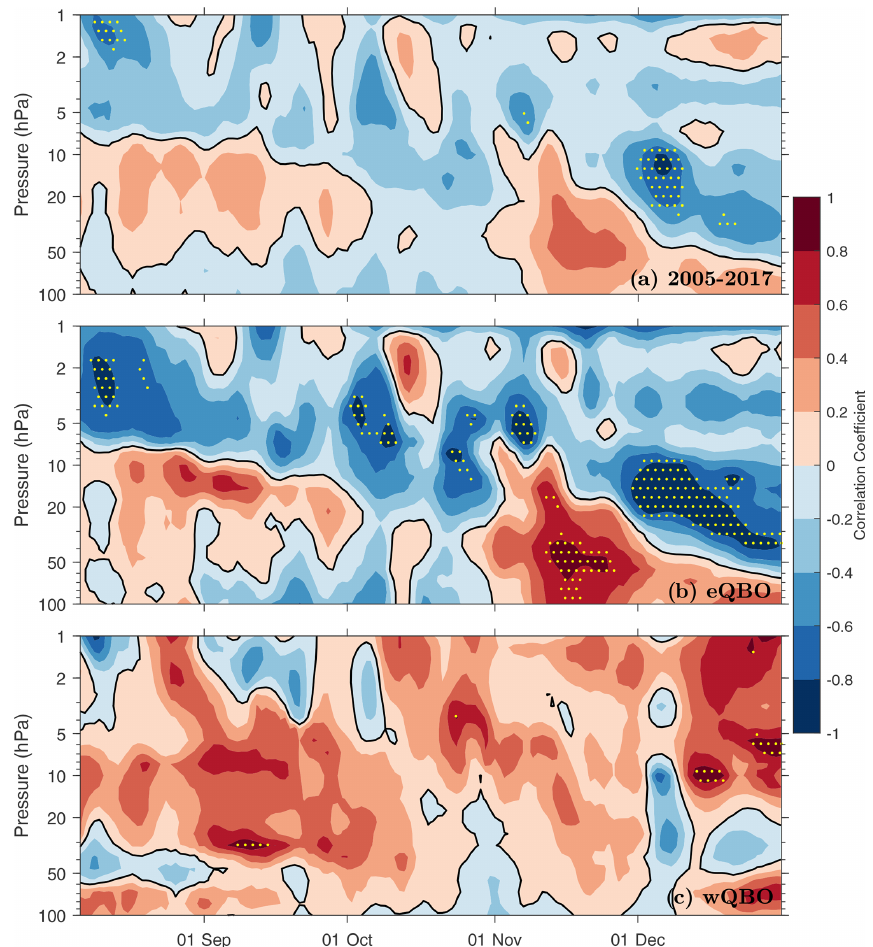
Figure 2. Correlation between the area-weighted polar (60–82 ◦ S) MLS ozone mixing ratio and (cid:99) Ap for (a) all years of the study, (b) eQBO years, and (c) wQBO years. The y axis is pressure (in hPa), and the x axis is time from the beginning of August until the end of December. Contours show the correlation coefficient with a 0.2 interval (black contour for zero), and stippling indicates statistical significance ( p < 0 .